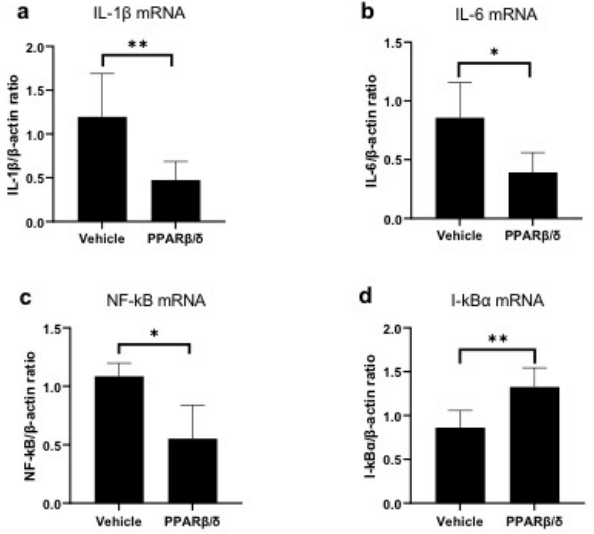
Figure 4. Immunohistochemical analysis of I- κ B α and quantitative evaluation determined by cell counting on the corneal periphery in each group. Representative sections at 6 h after injury are shown ( a , b ). PPAR β / δ group exhibited strong expression of I-kB α as compared to the vehicle group (see boxed area). Representative sections at day 4 after the injury are shown. I- κ B α expression was only found in the PPAR β / δ group ( c , d ). Higher magnification pictures of the boxed area are also shown. Bar, 50 µ m. There was a significantly higher number of I- κ B α -positive cells in the PPAR β group versus the vehicle group at each of the time points ( e ). Data are presented as mean ± SD ( n = 8) ** p < 0.01.